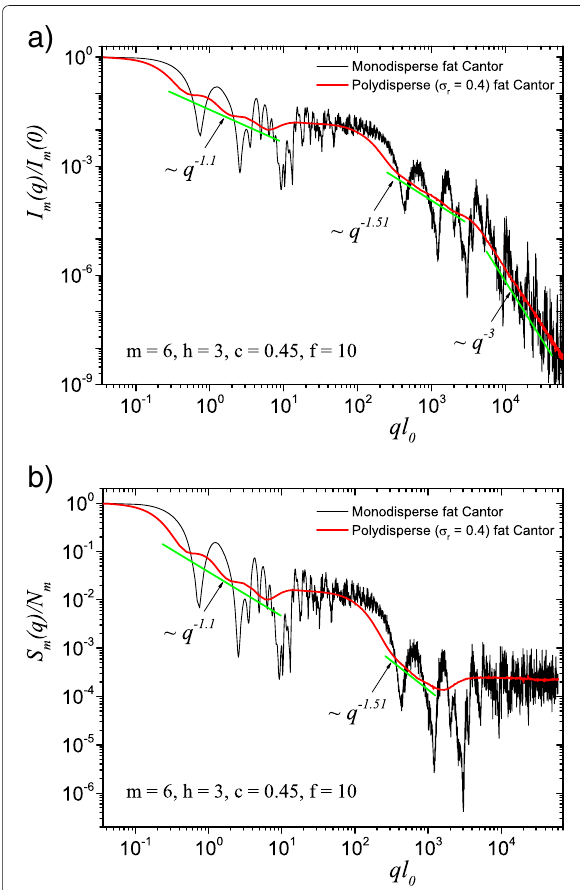
Fig. 4 (Color online) A comparison between monodisperse and polydisperse systems: a scattering intensity (Eq. (22)); b structure factor (Eq. (24)), averaged over all orientations of the fractal, according to Eq. (25). Here, f = 10 (and thus, a region of constant intensity appears at about 20 (cid:3) ql 0 (cid:3) 100), m = 6, h = 3 (i.e., the scaling factor is kept constant for three consecutive iterations), and the basic shape is a square of initial edge length l 0 = l in . For both cases, the polydispersity smears out monodisperse scattering curves, and the fractal dimensions can be recovered at each structural level